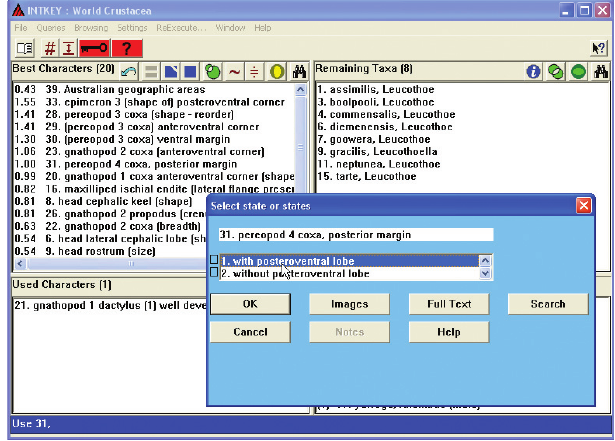
Figure 66. Character 31 is another well visible trait, it has the ideal Best index of 1.0.